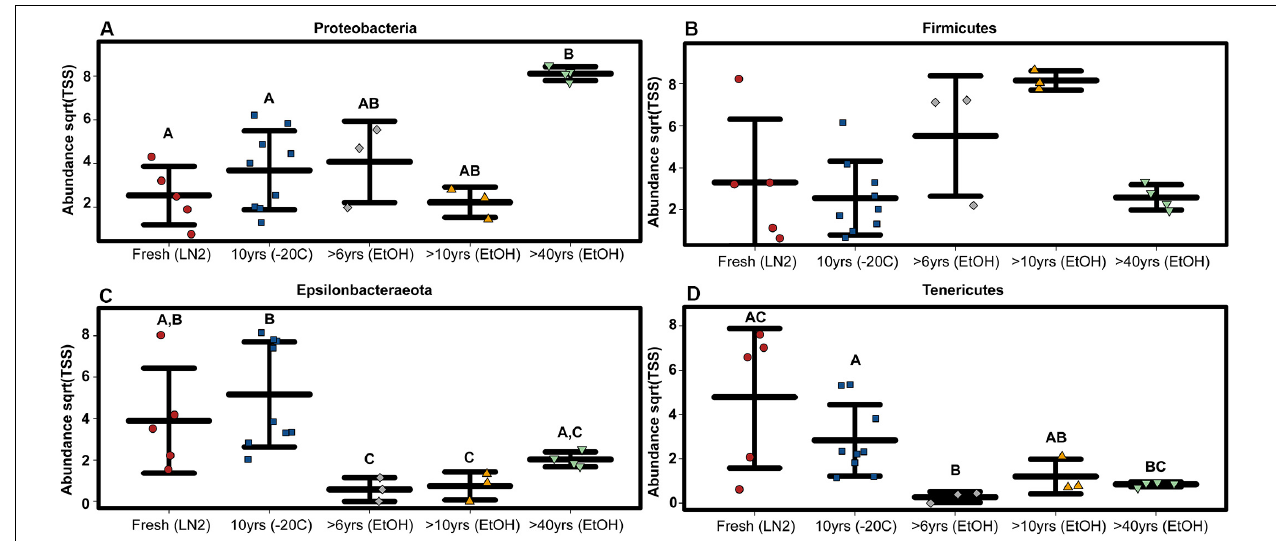
FIGURE 4 | ASV based variation in phylum abundance across sample age for (A) Proteobacteria, (B) Firmicutes, (C) Epsilonbacteraeota, and (D) Tenericutes. Significant differences based on non-parametric Kruskal-Wallis tests ( P < 0.05) are indicated by letters above the